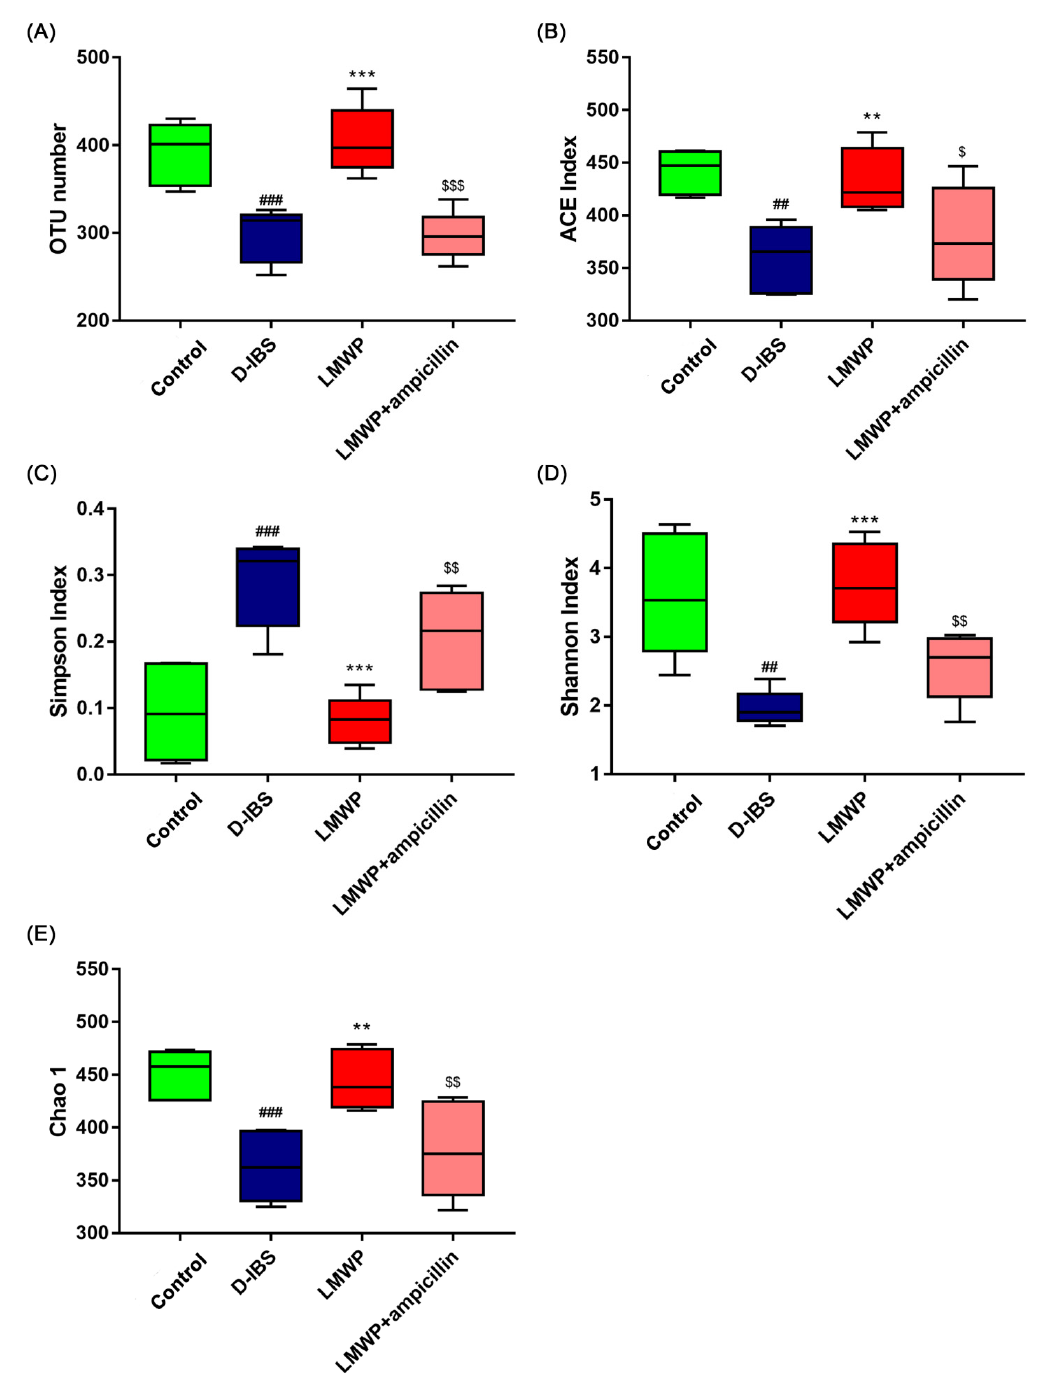
Figure 7. The diversity, richness and structure of the gut microbiota in response to LMWP (S3-3) from the larvae of Musca domestica in D-IBS mice. ( A ) The number of OTUs in the gut microbiota. ( B – E ) The ACE index, Simpson index, Shannon index and Chao1 index. Values are presented as means ± SD ( n = 5). ## p < 0.01 and ### p < 0.001 compared with Control, ** p < 0.01 and *** p < 0.001 compared with D-IBS, $ p < 0.05, $$ p < 0.01 and $$$ p < 0.001 compared with LMWP (S3-3) from the larvae of Musca domestica